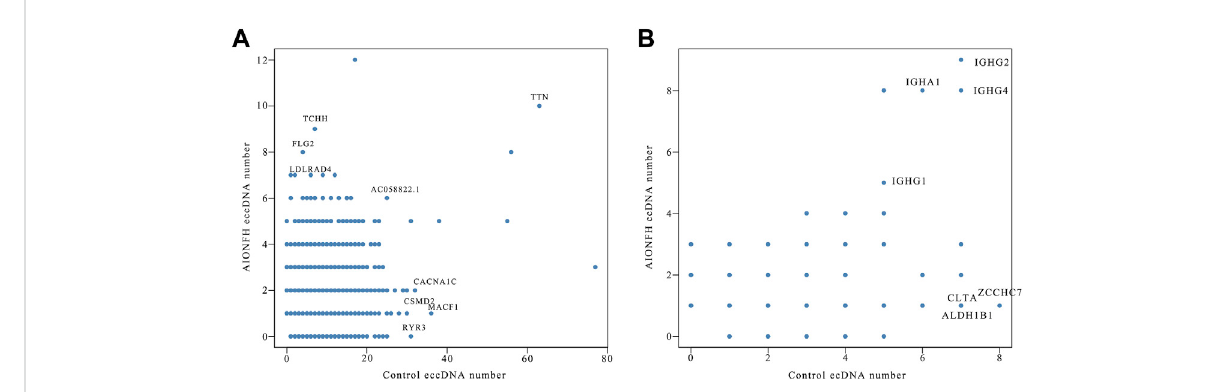
FIGURE 7 Correlation analysis of eccDNAs (A) and ecDNA (B) quantity between AIONFH group and control